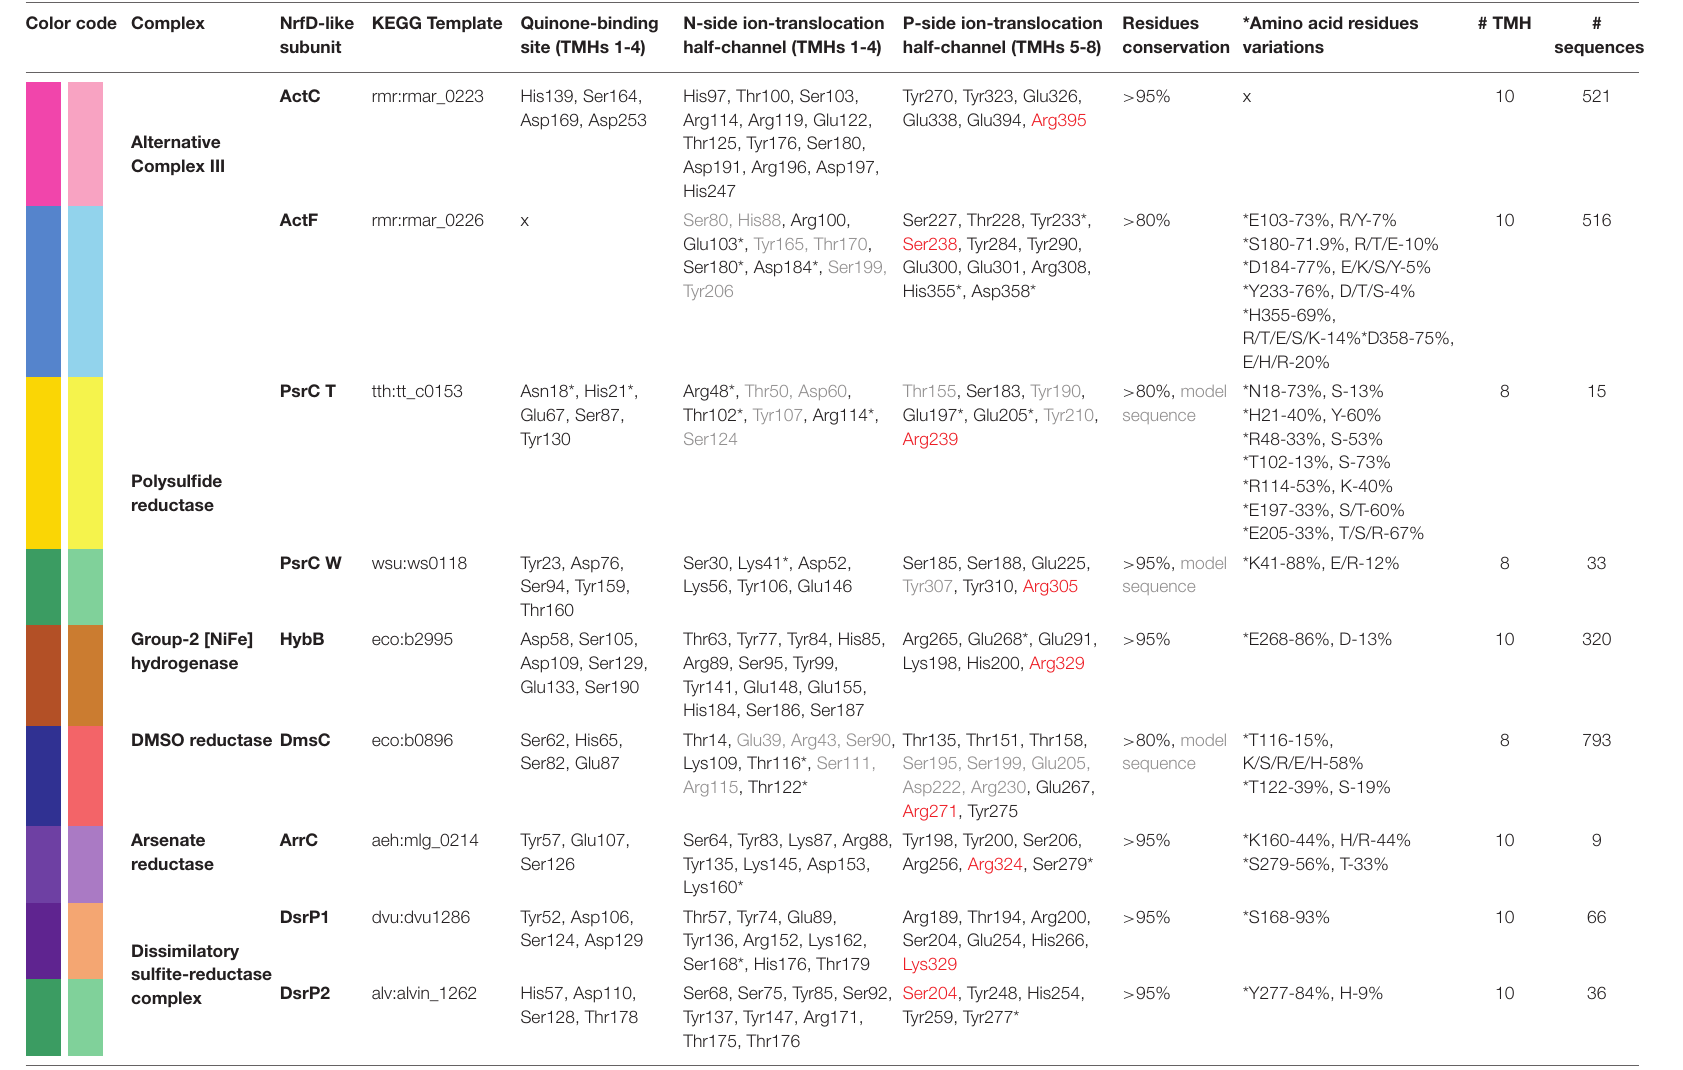
TABLE 2 | Amino acid residues conservation in NrfD-like subunit-containing